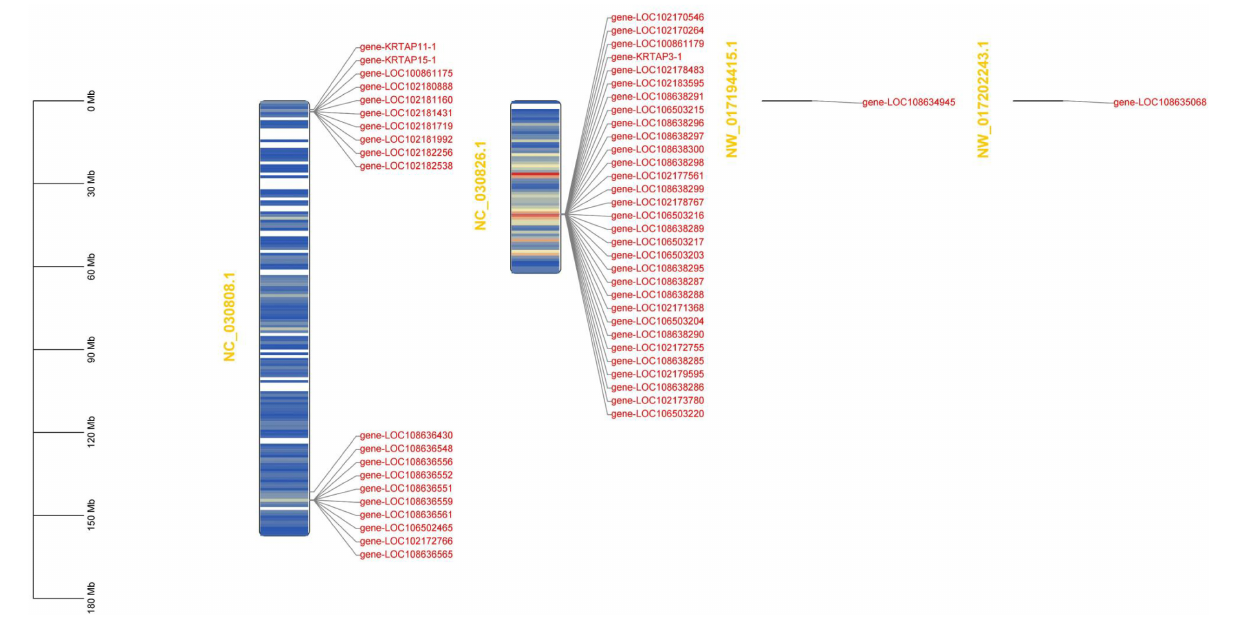
FIGURE 1 | Chromosomal mapping of 53 high-sulfur protein